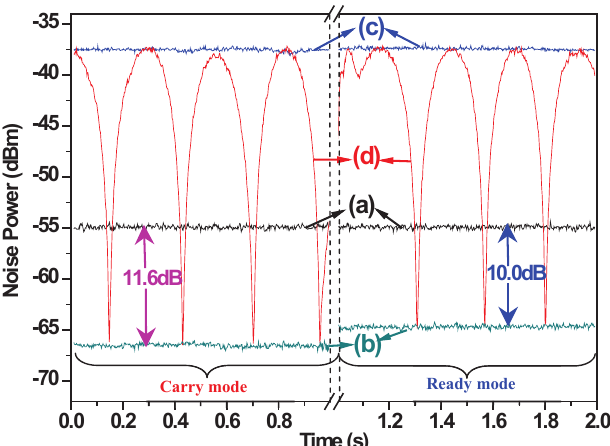
Figure 4. Balance homodyne measurements of the quadrature noise variances with the sequential control scheme. The measurement was recorded at a Fourier frequency of 2 MHz, with an resolution bandwidth (RBW) of 300 kHz and a video bandwidth (VBW) of 200 Hz. The data represent direct observations and contained electronic noise.